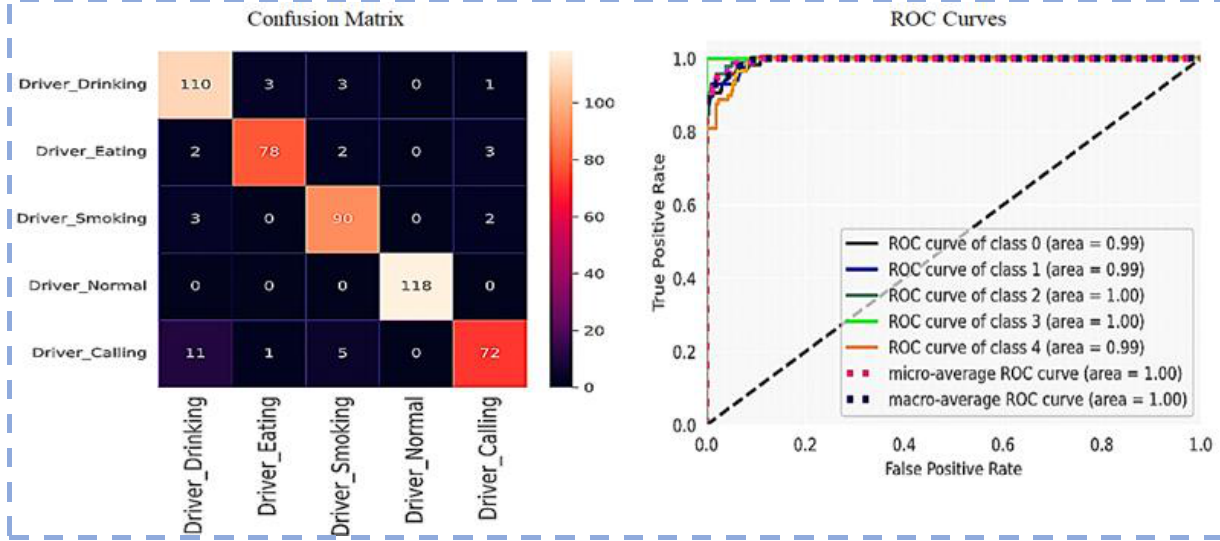
Figure 13. Confusion matrix and ROC Curves using Inception-v3.